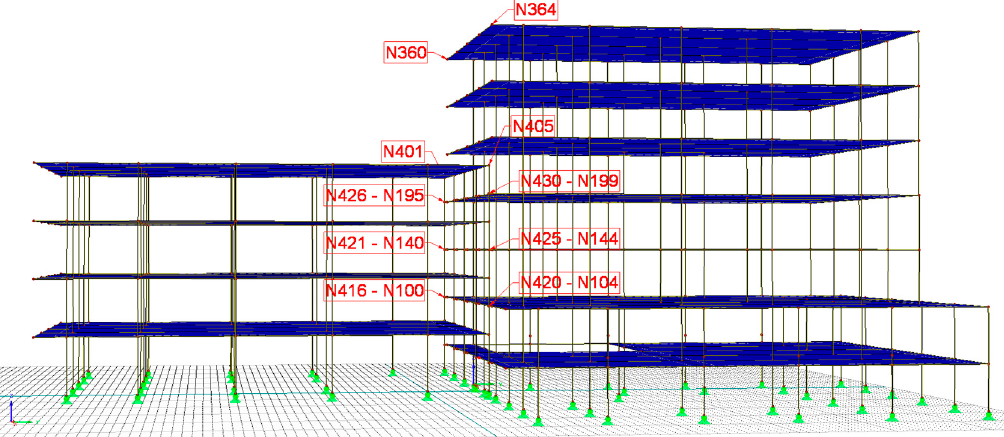
Figure 9. The arrangement of representative nodes.